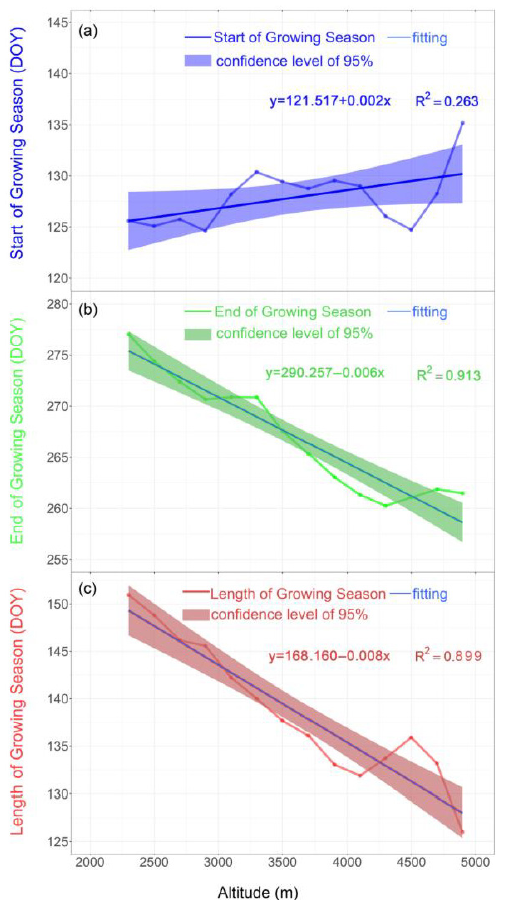
Figure 3. Characteristics of the changes in the SOS ( a ), EOS ( b ), and LOS ( c ) with altitude. Figure 4b,d,f and Table 1 show the spatial distribution of the vegetation phenology